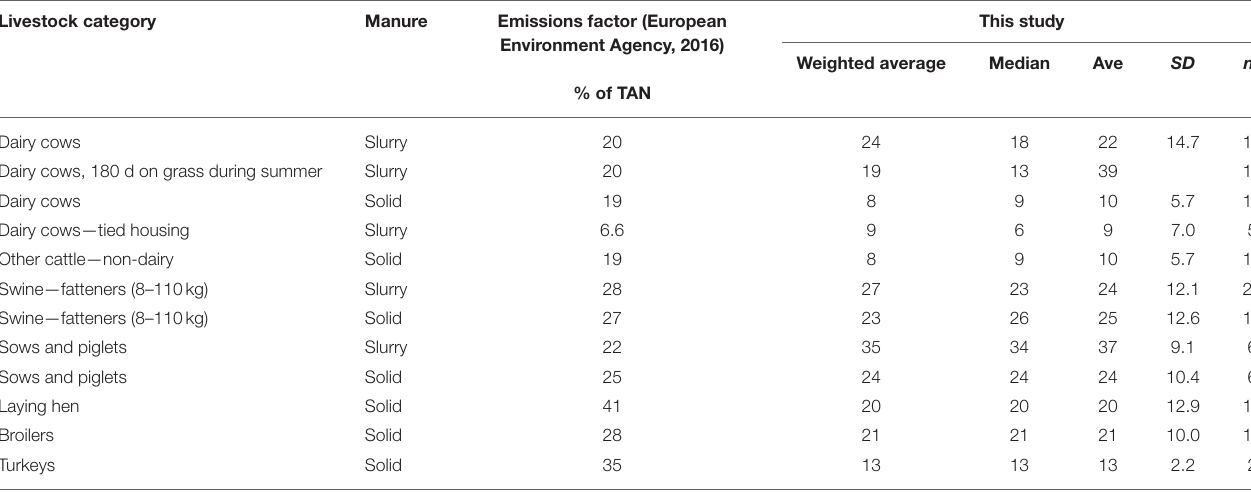
TABLE 5 | Ammonia emission from livestock buildings given as a % of TAN content in the manure stored in the animal house (references to articles providing data for each category can be found in the Excel spreadsheets in the Supplementary Material ). Livestock category